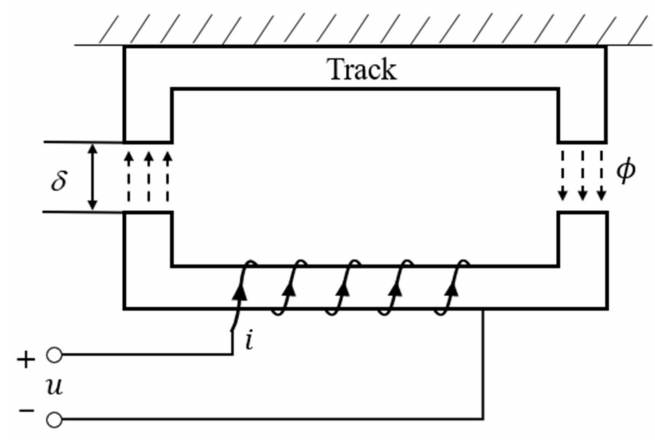
Figure 1. Simplified structure of the single point suspension